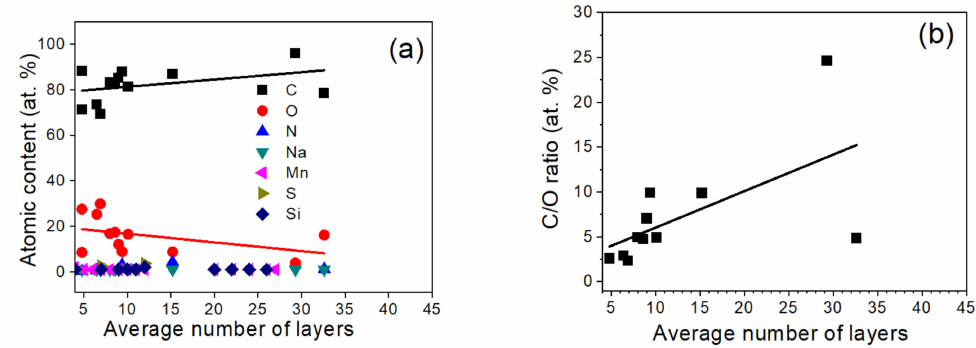
Figure 6. XPS determined: ( a ) surface atomic content ( b ) ratio of C to O atomic content dependent on the average number of layers in the investigated